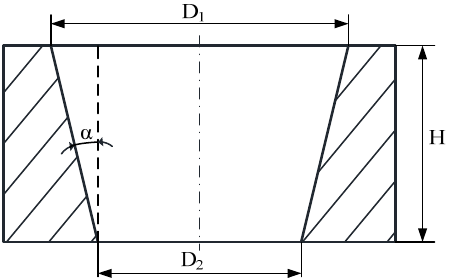
Figure 5. Schematic diagram of the through-hole taper.